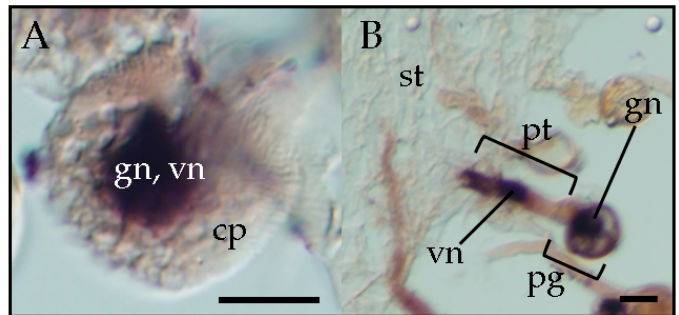
Figure 2. In situ hybridization shows the presence of potato spindle tuber viroid (PSTVd) in the generative nucleus and vegetative nucleus of, respectively, infected mature pollen grains ( A ) and infected germinating pollen grains on healthy stigma ( B ) in PSTVd-infected petunia. cp, cytoplasm; gn,